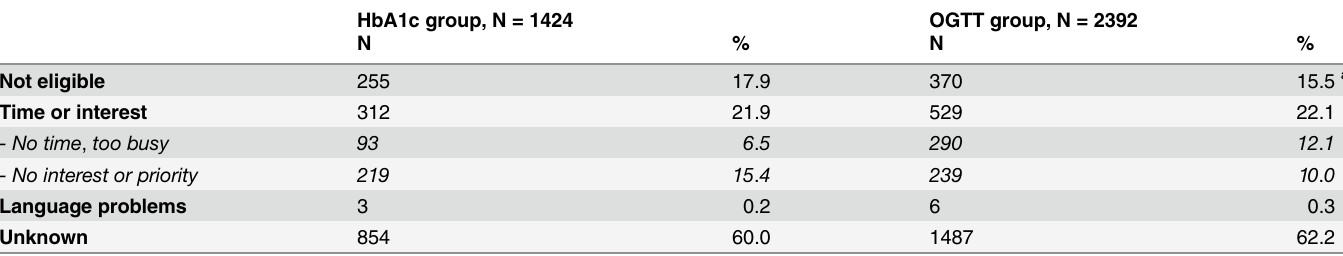
Table 2. Reasons for non-response in the HbA1c group and the OGTT group. OGTT group = people offered screening by means of an oral glucose tol- erance test; HbA1c group = people offered screening by means of a glycated hemoglobin measurement; Not eligible = outside age range, longterm